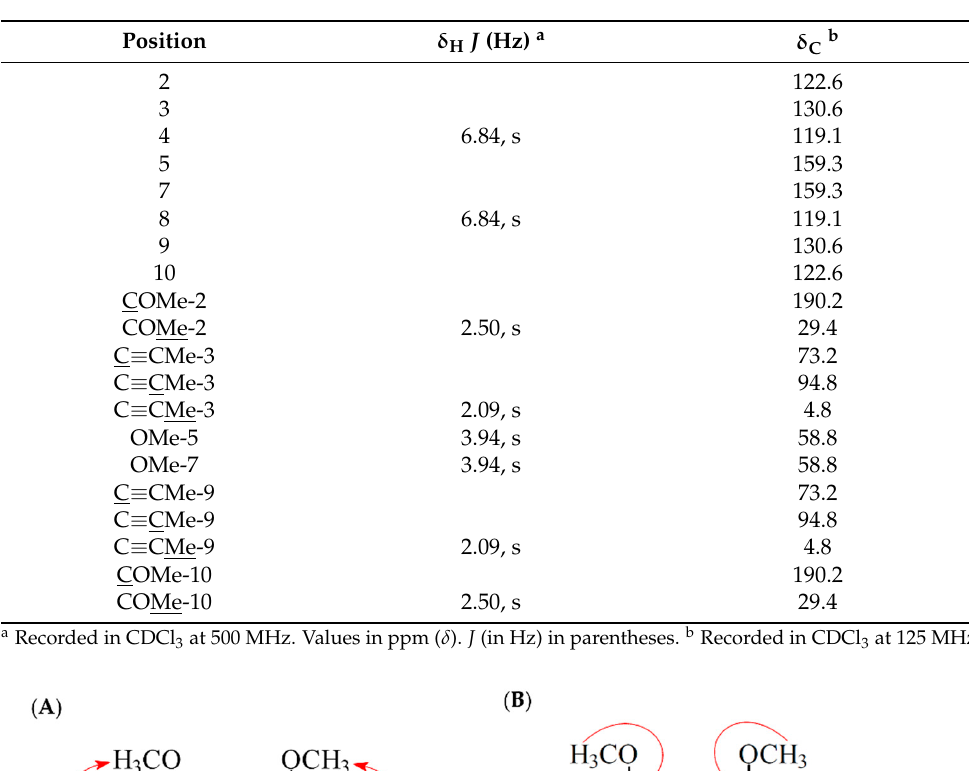
Table 4. 1 H and 13 C NMR data of 5 .